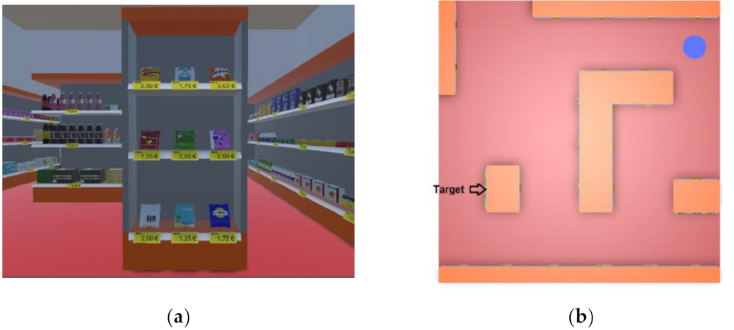
Figure 5. ( a ) The virtual shelf containing the snacks, ( b ) the position of the target shelf in the virtual